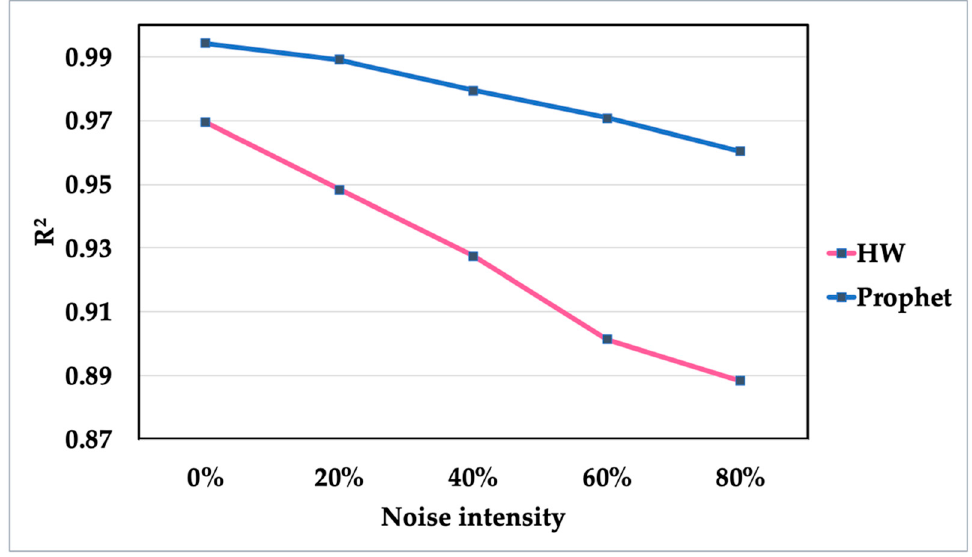
ffi cient of determination at di ff erent noise intensities for both Figure 10. Variations of the coefficient of determination at different noise intensities for both models. Figure 10. Variations of the coe